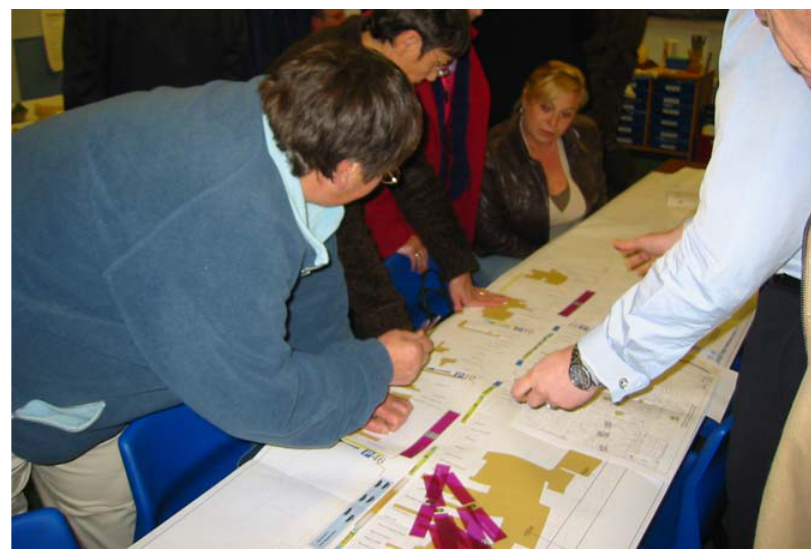
Figure 12. Participants redesigning their high